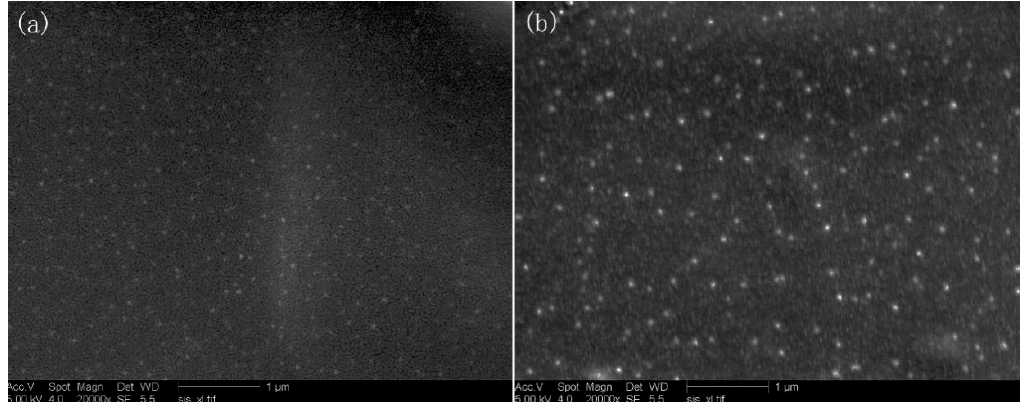
Figure 3. SEM images of ( a ): 5 wt % QD-CMC and ( b ): 15 wt % QD-CMC composites.